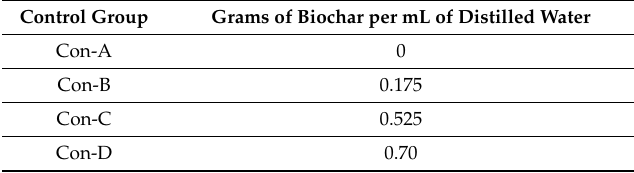
Table A2. Control groups for the two-factor